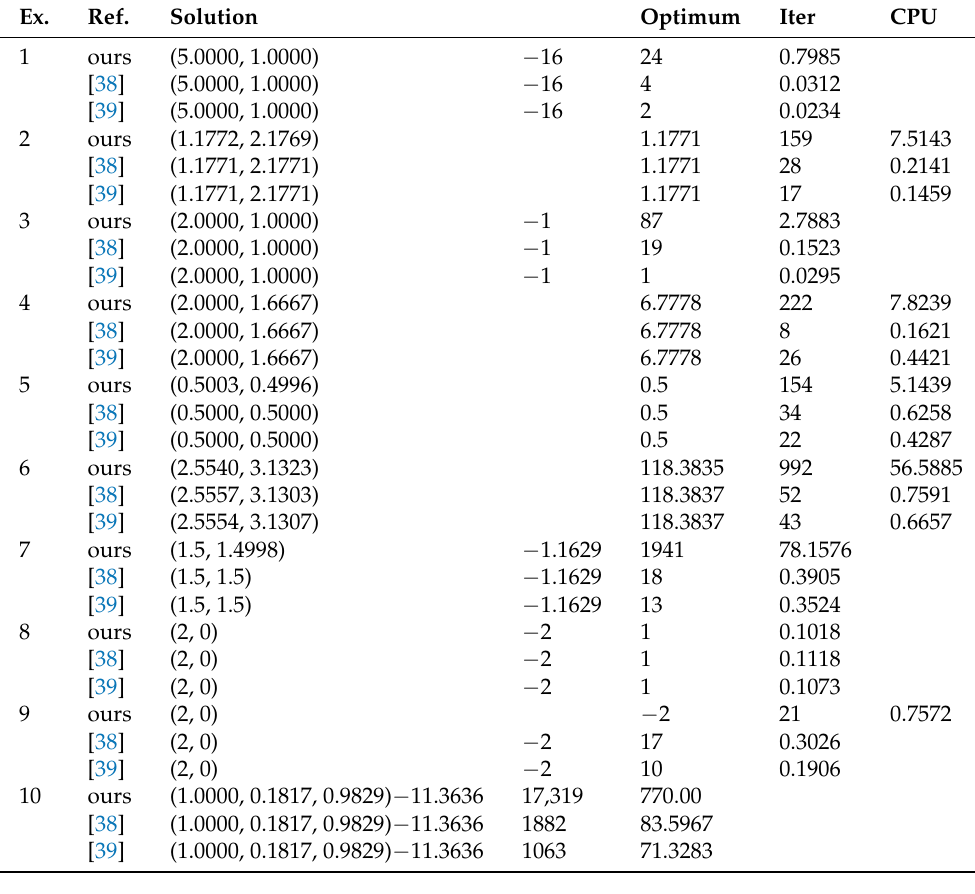
Table 1. Numerical results in Examples